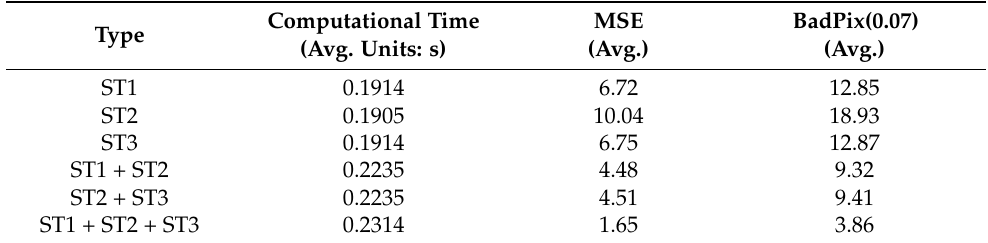
Table 3. Performance comparison of networks with the different number of input streams.